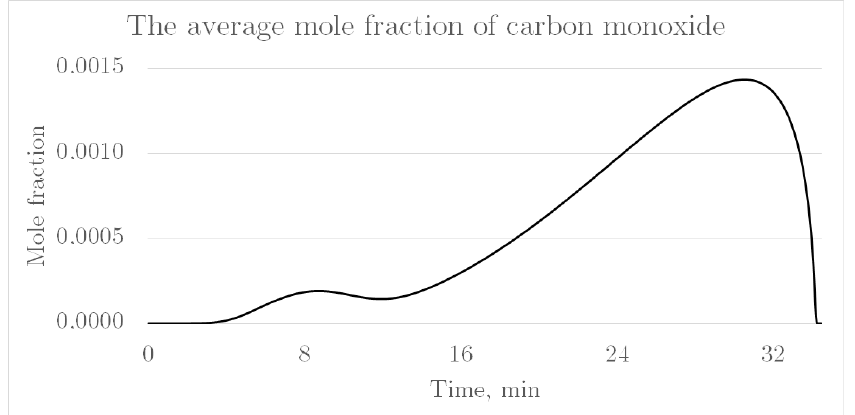
Figure 9. Dynamics of the average molar fraction of carbon monoxide in the reaction mixture in the pores of the catalyst grain.